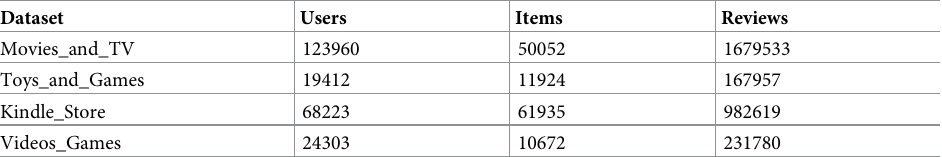
Table 1. Statistics of